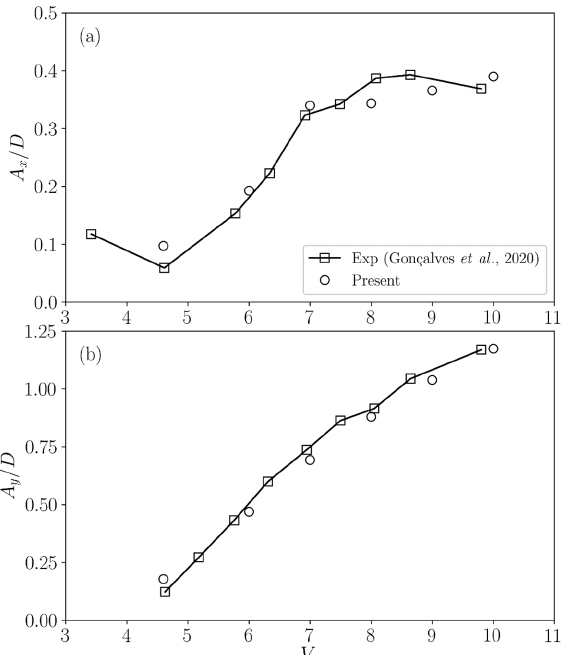
Figure 4. Non-dimensional vortex-induced motion amplitude of the four-column floating platform in validation test: ( a ) inline direction; ( b ) transverse direction.